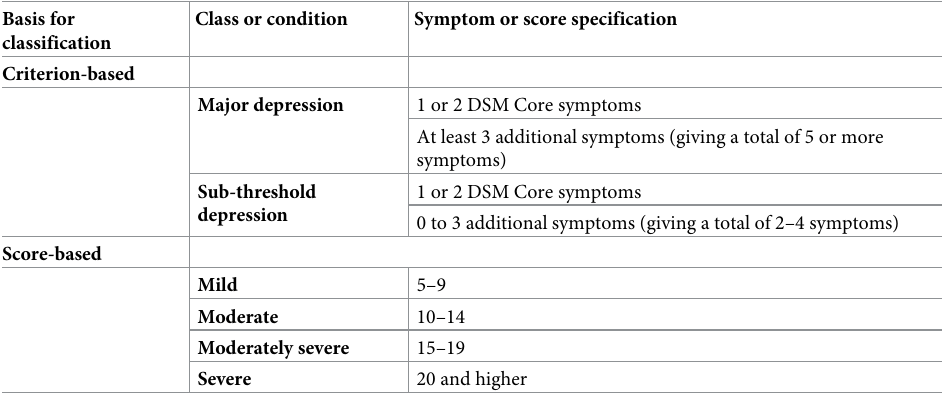
Table 1. Depression diagnosis: Criterion based and score based